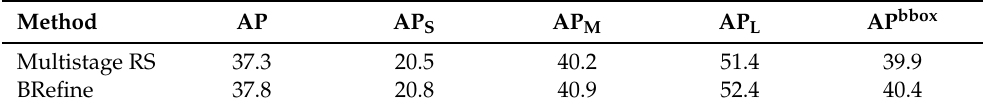
Table 6. The effectiveness of boundary region